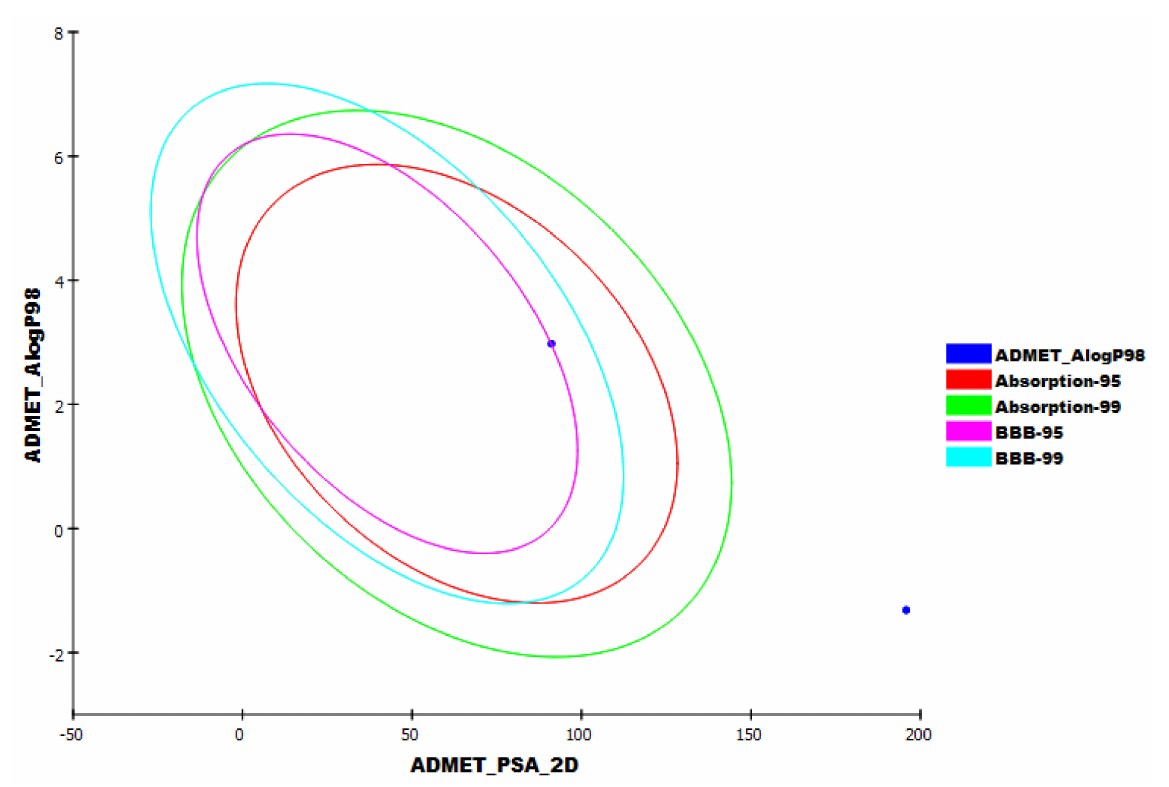
Figure 12. The expected ADMET study.